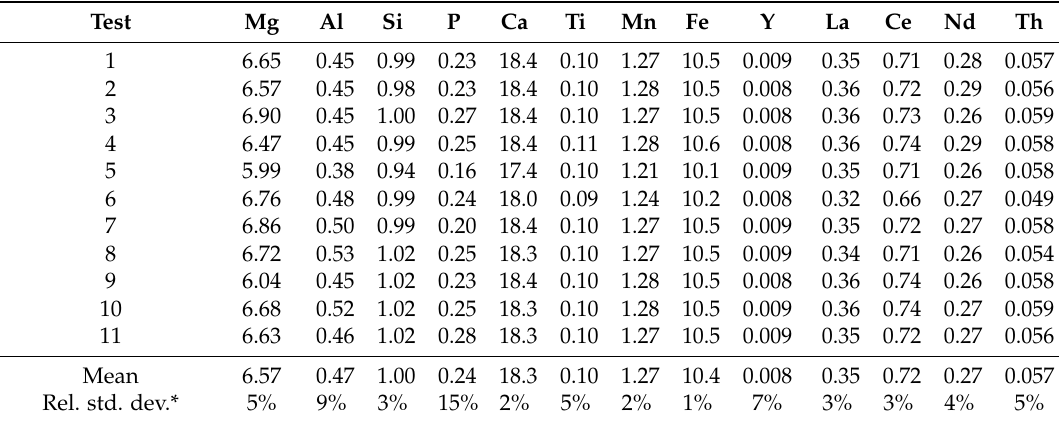
Table 5. Calculated flotation feed elemental compositions (wt %).